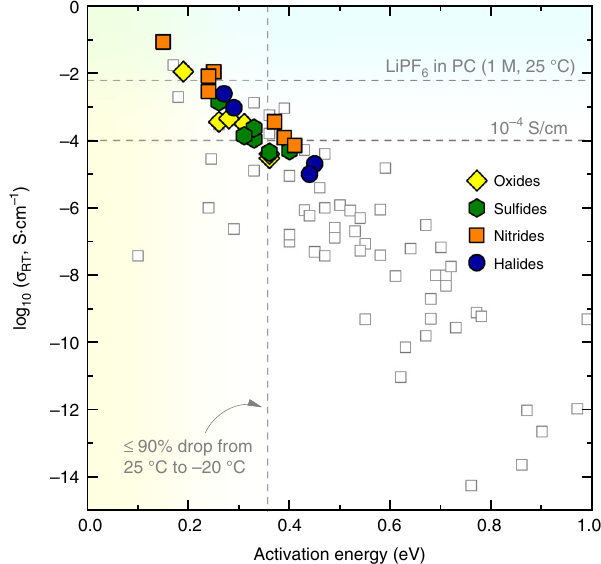
Fig. 3 Ion conducting properties of newly predicted versus known solid- state Li-ion conductors. The open symbol shows the experimental conductivity reported in the literature (Supplementary Table 2 and references therein). The horizonal dashed lines show the room temperature conductivity of 10 – 4 and 0.006 S cm − 1 . The latter value is the conductivity of 1 M LiPF 6 in propylene carbonate (PC) solution. The vertical dashed line shows the activation energy at 0.356 eV, which corresponds to one order of magnitude change of conductivity when the temperature drops from 25 to − 20